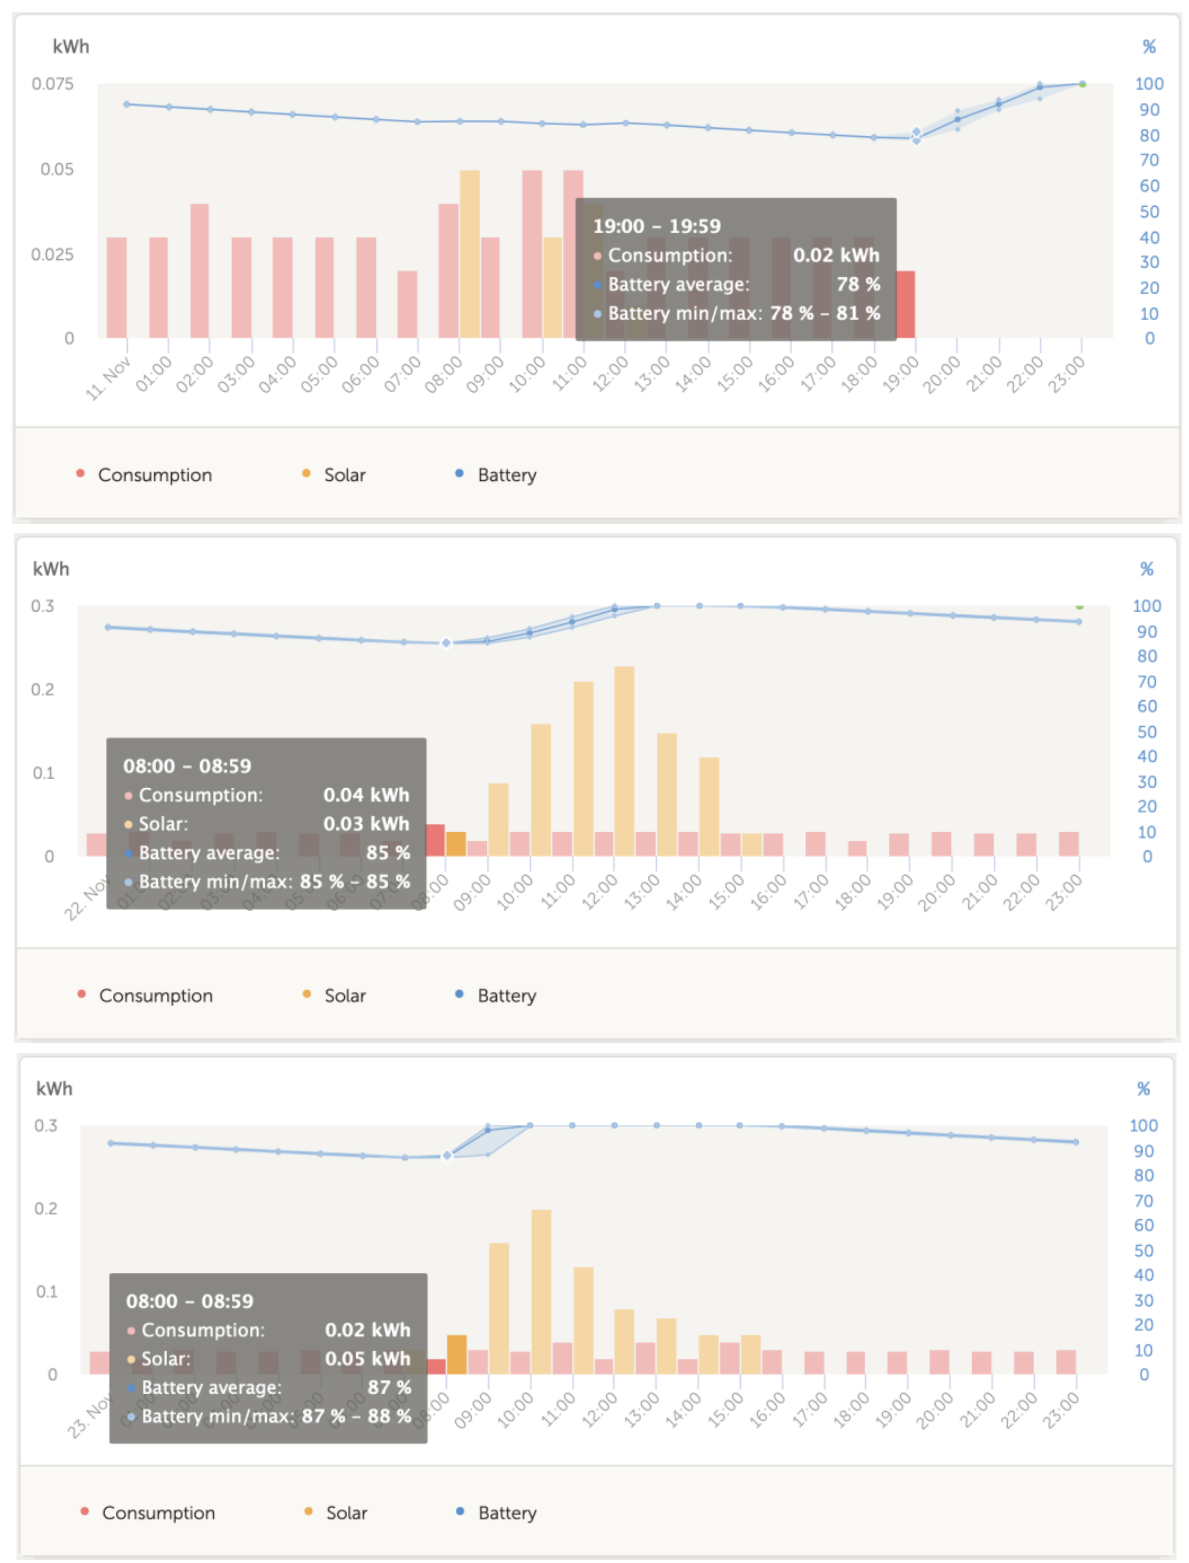
Figure 22. Adequate confinement SOC range for gel batteries.